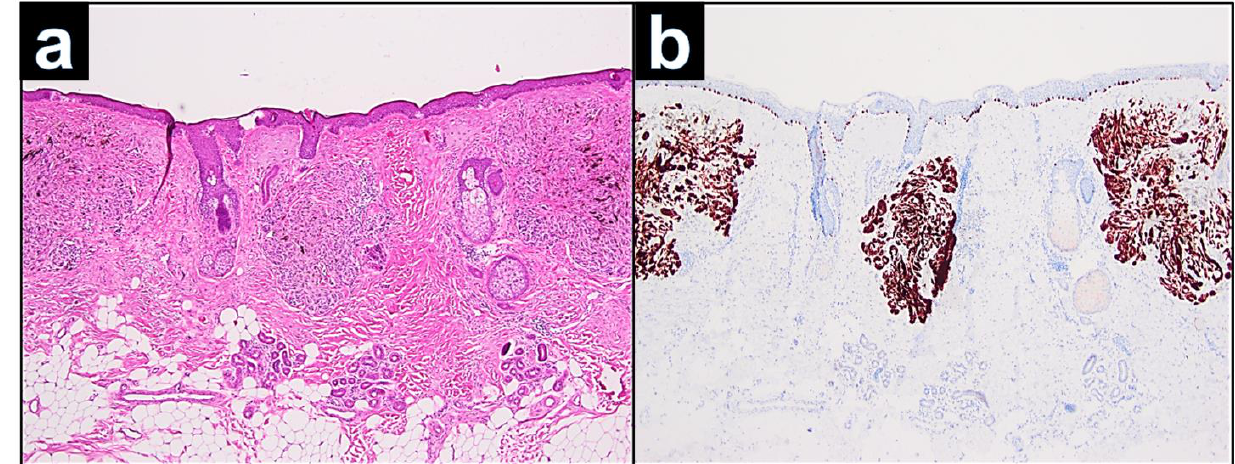
blue nevus with ovoid and dendritic melanocytes (H&E, 40×). Inset H&E ×400. ( b ): Positivity of the